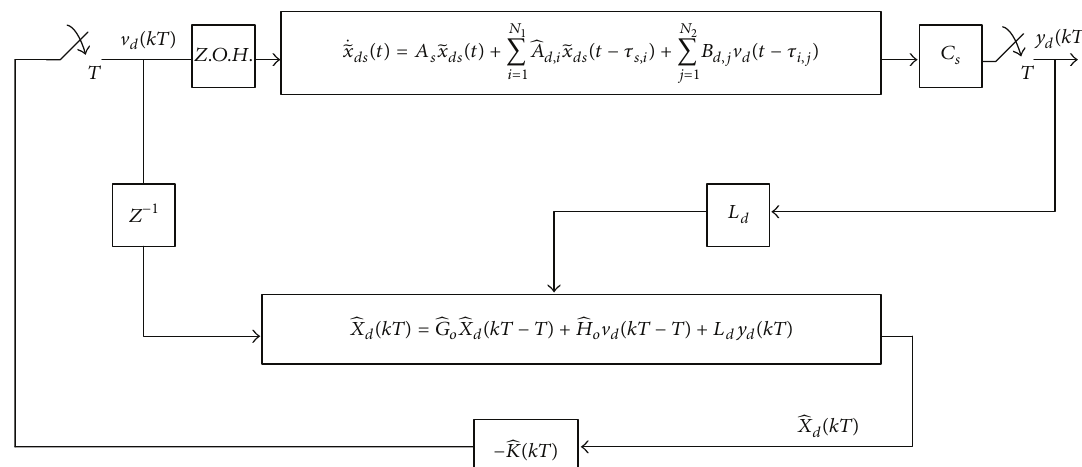
Figure 2: Observer-based suboptimal tracker for the digitally redesigned time-delay singular system.